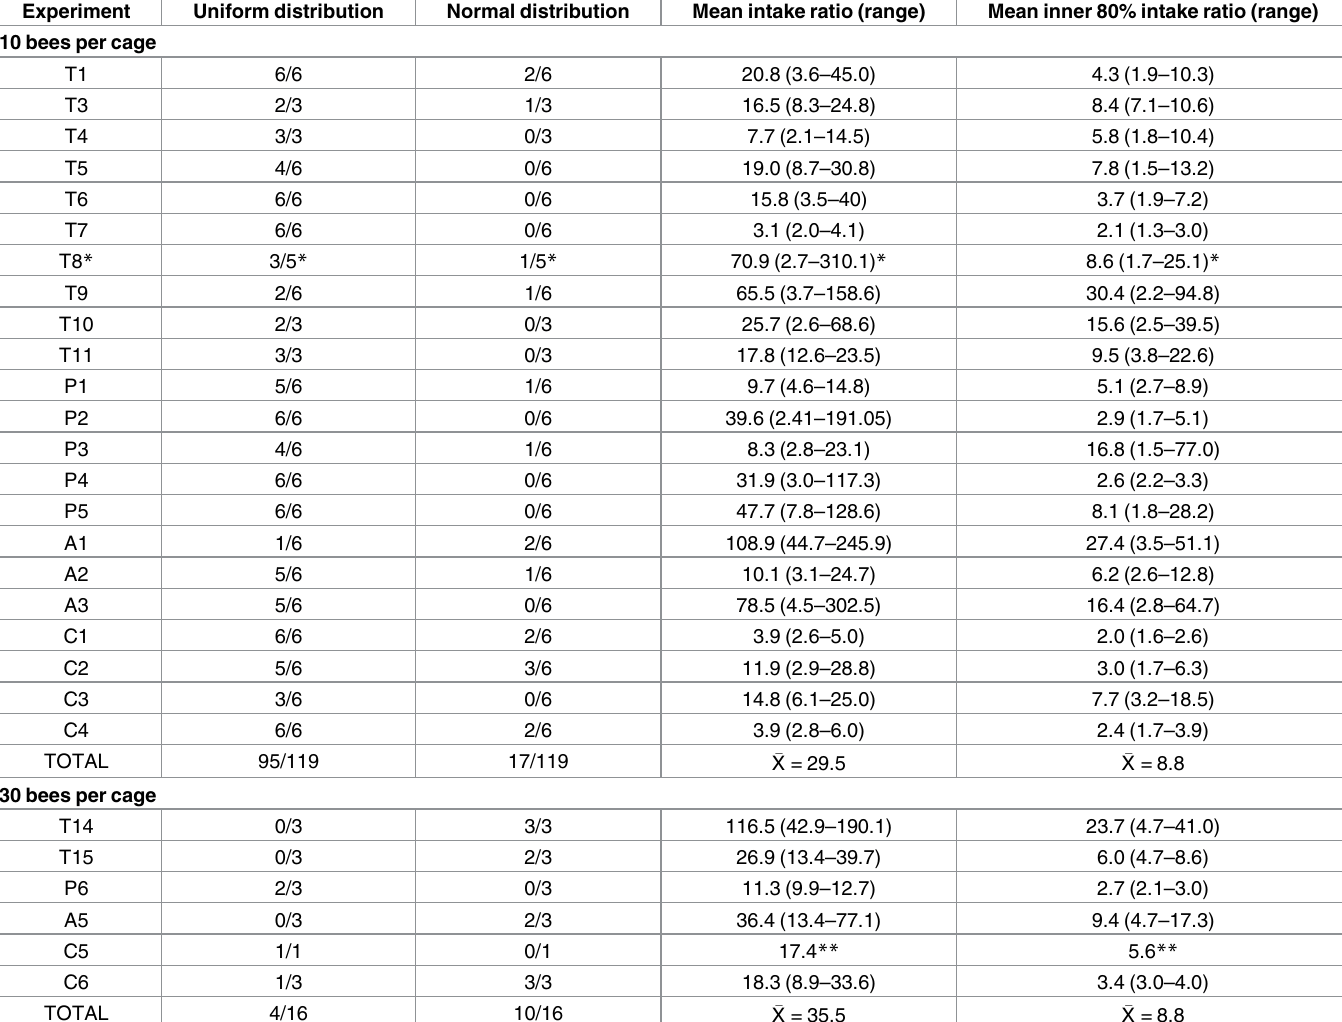
Table 3. Abundance of cages with a uniform and normal distribution of a labelled sugar solution diet for all replicates for temporary 1 (T) and per- manent 2 (P) feeding regimes without imidacloprid and for acute 3 (A) and chronic 4 (C) feeding regimes with imidacloprid. Mean and range (min- max) for full range intake ratio and inner 80% intake ratio are shown for each